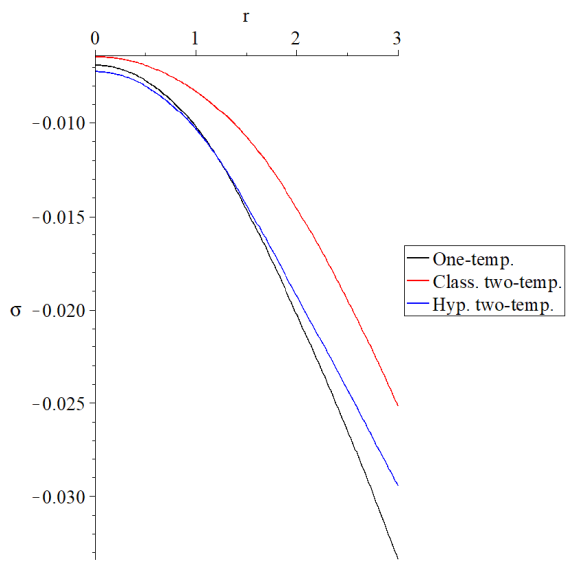
Figure 6. The distribution of the average stress for the variance values of the two-temperature parameter when D = 0.2 .